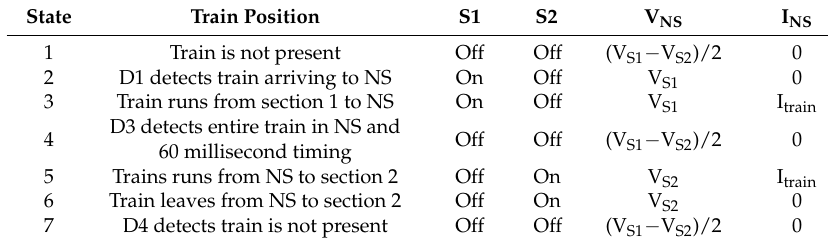
Table 1. Transition states when a train runs through the neutral section from section 1 to section